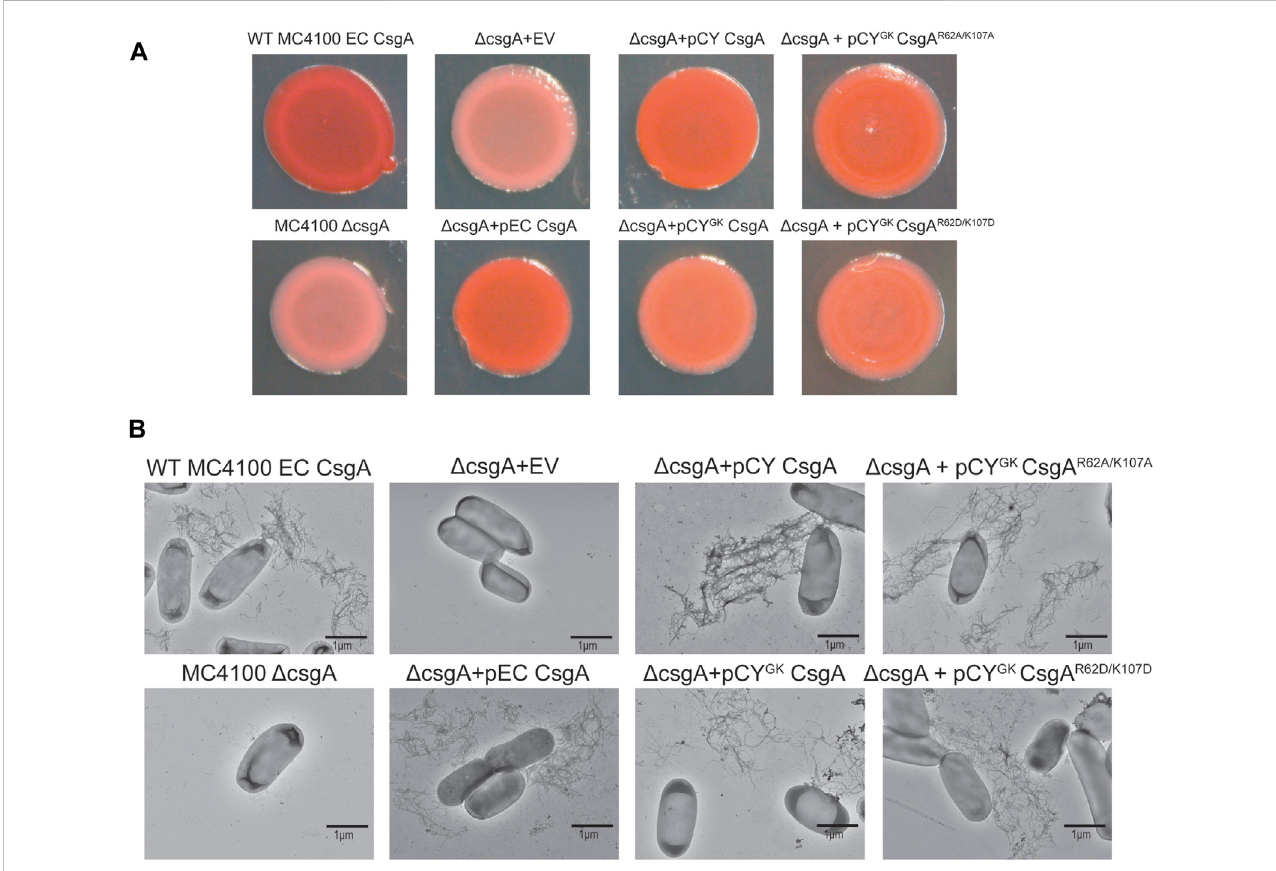
FIGURE 7 Complementationassay ofCY GK CsgA bacterialmutants. (A) E.coli MC4100 Δ csgA cells transformedwithplasmidsencodingthedifferentCsgA mutants under the native E. coli csgBAC promoter and fused to E. coli CsgA sec signal sequence spotted on YESCA-Congo red indicator plates incubated for 48 h at 26 ° C (EV, empty vector). (B) Representative negative stain transmission electron micrographs of wild-type E. coli MC4100, E. coli MC4100 Δ csgA , E.